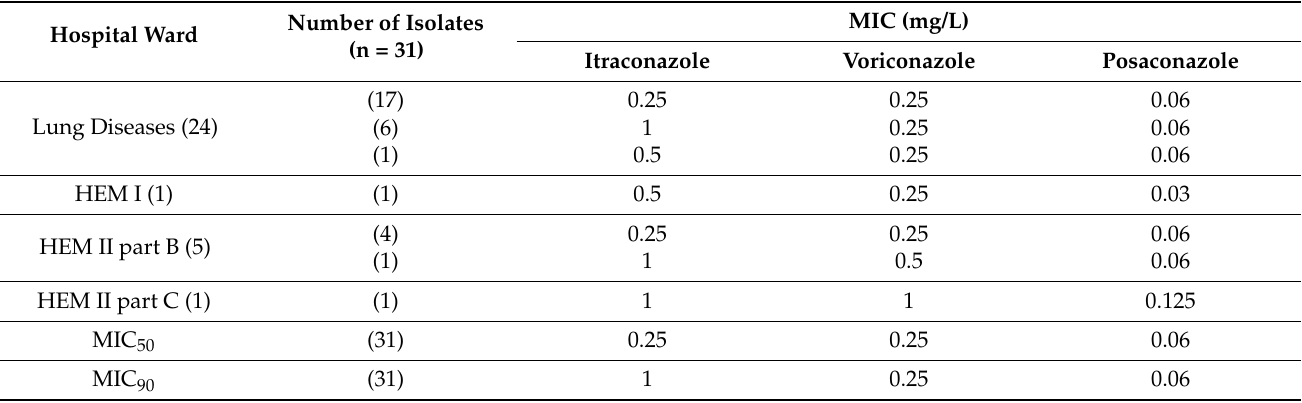
Table 3. Minimal inhibitory concentrations (mg/L) of itraconazole, voriconazole and posaconazole against isolates of Aspergillus fumigatus species